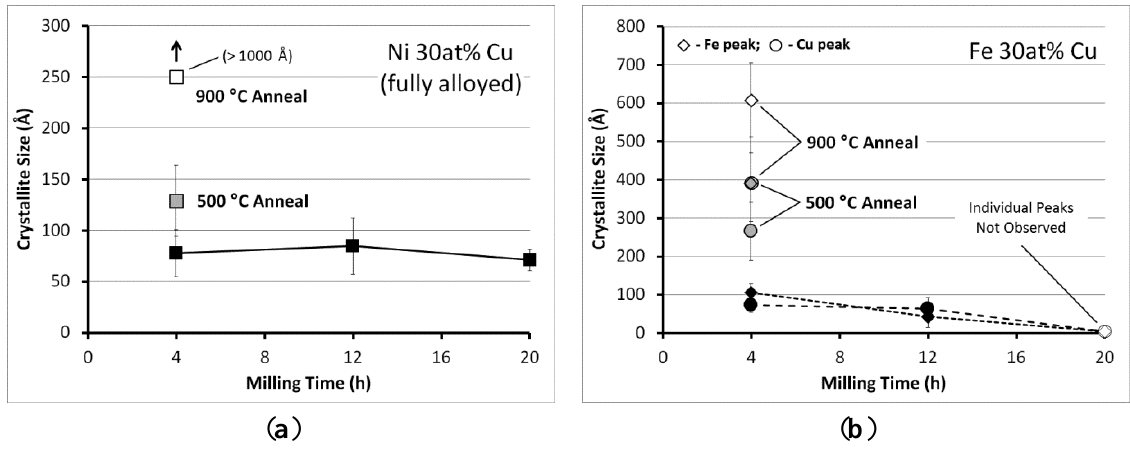
Figure 3. Scherrer crystallite size estimates for ( a ) Ni 30 at% Cu and ( b ) Fe 30 at% Cu as a function of milling time and after annealing the powder milled for 4 h. Data for Fe 30 at% Cu are represented by two points at each condition, one corresponding to Fe peaks (diamonds) and the other to Cu peaks